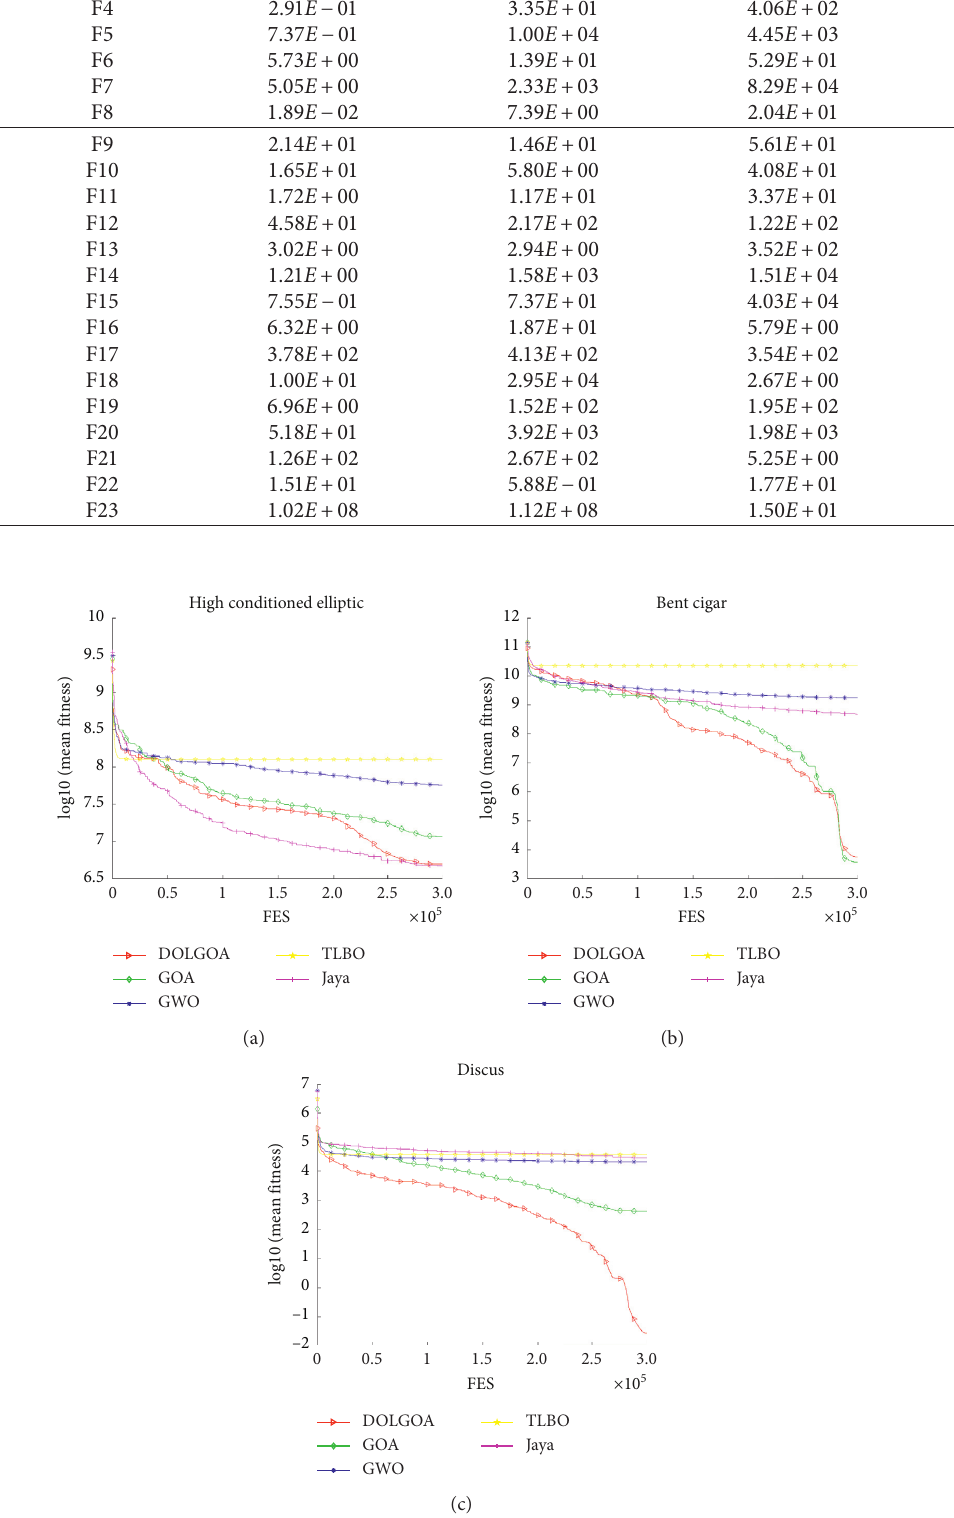
Figure 2: The convergence trends of all algorithms on unimodal